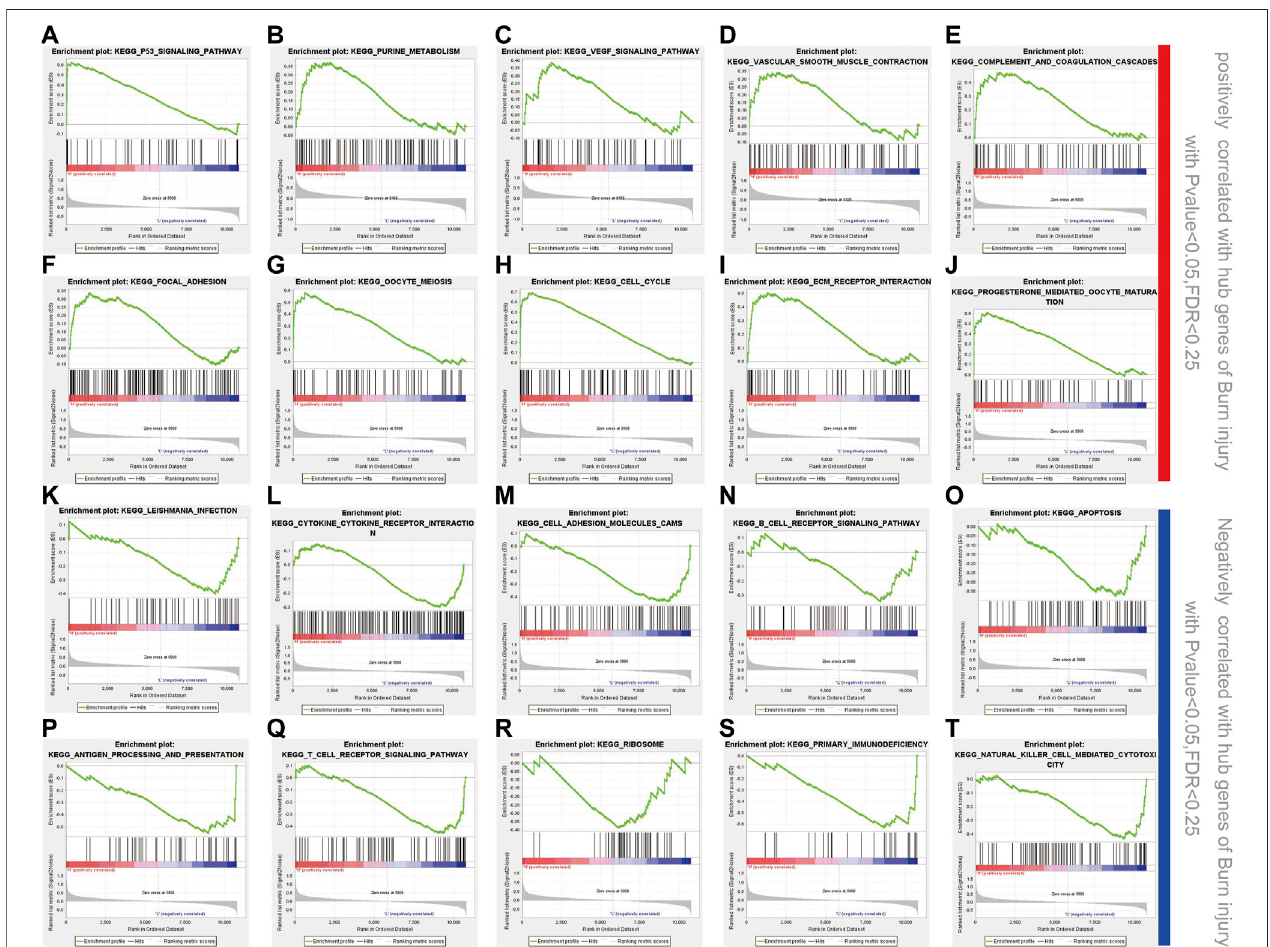
FIGURE 6 | GSEA enrichment analysis. (A-J) 10 positively correlated pathways in burn injury; (K-T) 10 negatively correlated pathways in burn injury.